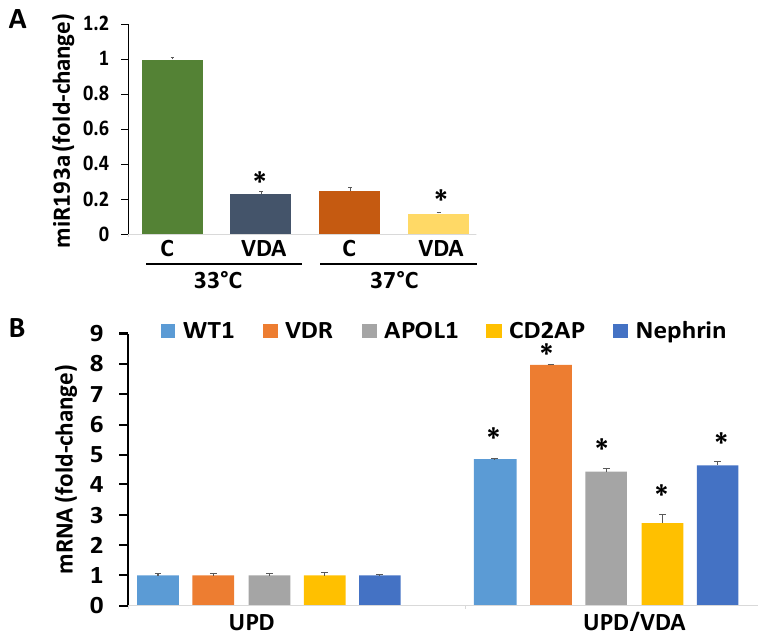
Figure 8. Evaluation of the effect of VDA on downing of miR193a and associated expression of podocyte molecular markers. ( A ) UPDs (at 33 °C) and DPDs (at 37 °C) were incubated in media containing either buffer (Control, C) or VDA (EB1089, 100 nM) for 48 h (n = 3). RNAs were assayed for miR193a expression. Cumulative data of three independent experiments are displayed in a bar diagram. * p < 0.05 compared with respective control (C). ( B ) B. cDNAs were prepared from RNA extracted from the protocol A, amplified with specific primers for WT1 , VDR , APOL1 , CD2AP , and Nephrin . Cumulative data are shown as bar graphs. * p < 0.05 compared respective controls (C). In brief, YY1/Sox2 expression as well down-regulation of WT1/ VDR: RXR de-represses the